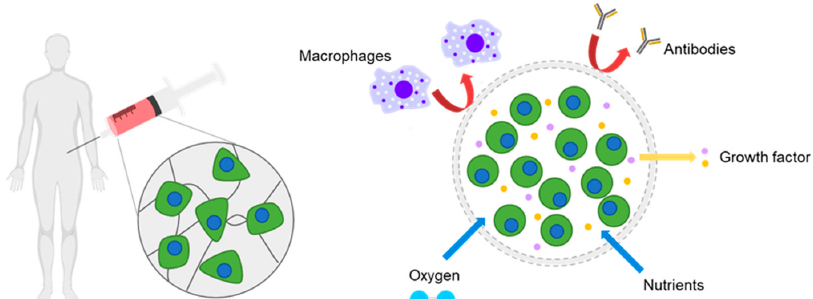
Figure 1. A schematic of the microencapsulation of stem cells and benefits in therapeutic